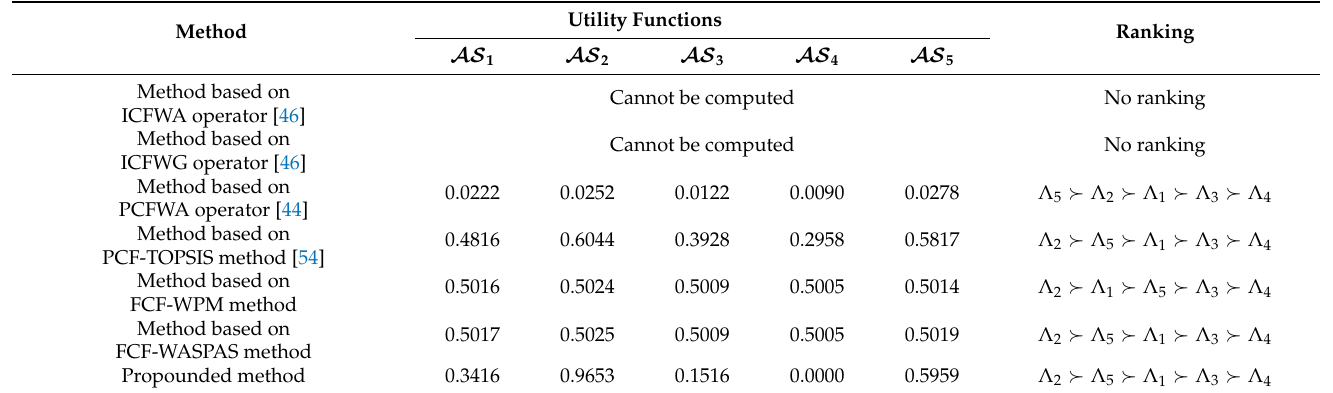
Table 10. Decision results attained by different